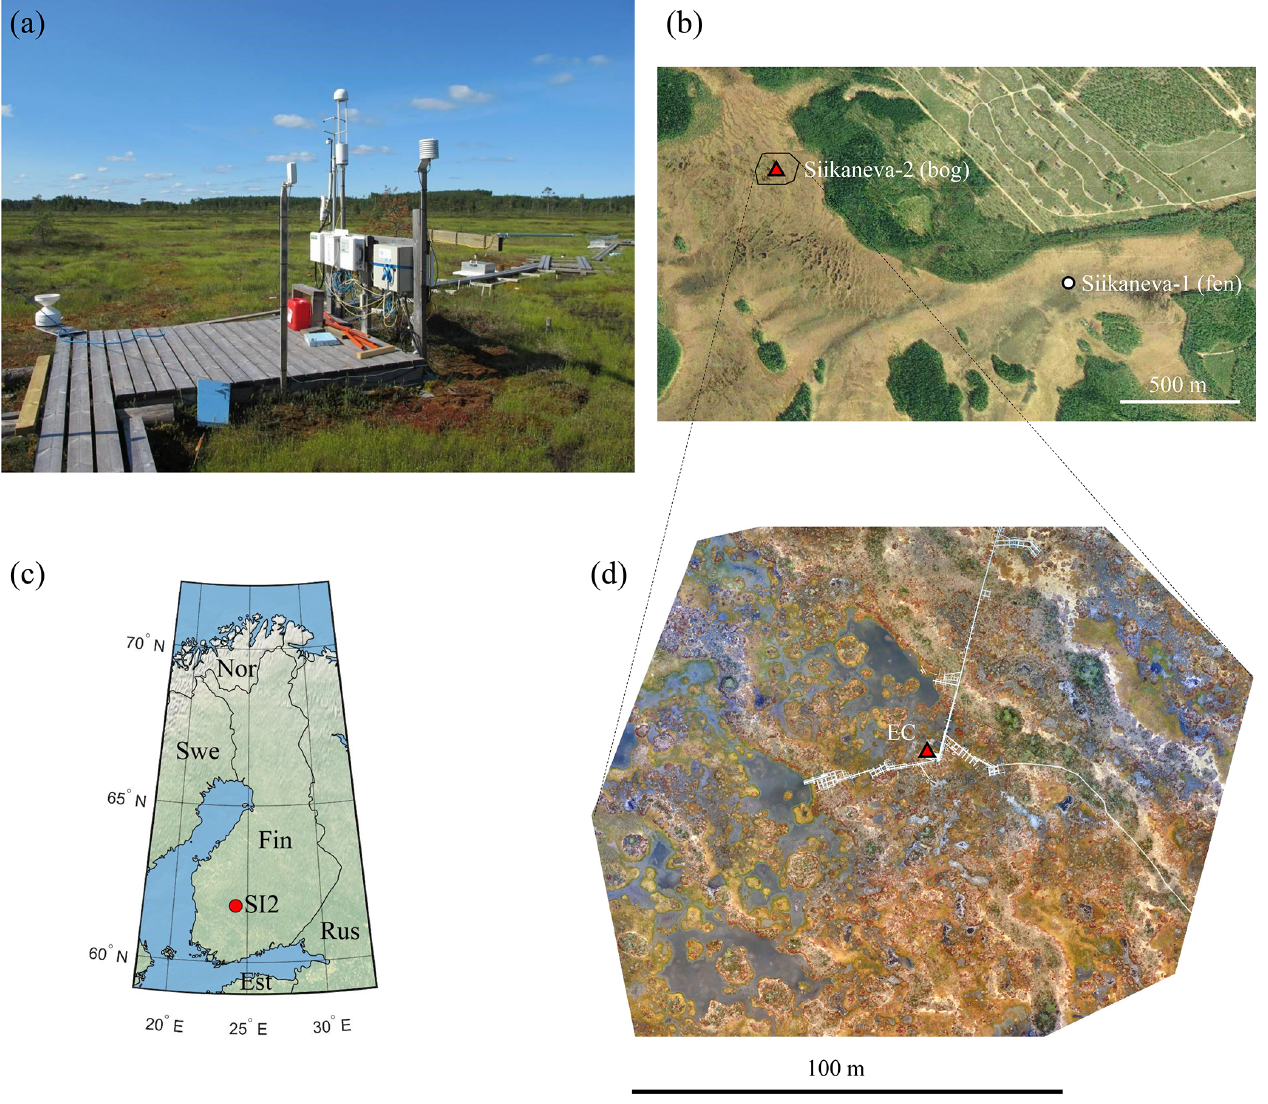
Figure 1. (a) Photo of the eddy-covariance tower and meteorological setup facing southwest. (b) Map of the Siikaneva mire with the bog (SI2, this study) and fen (SI1, Rinne et al., 2018) sites marked. (c) Map of Finland showing the location of the Siikaneva-2 site. (d) Aerial RGB orthomosaic showing the main EC footprint contribution zone, based on the imagery obtained on 18 June 2018 during a dry